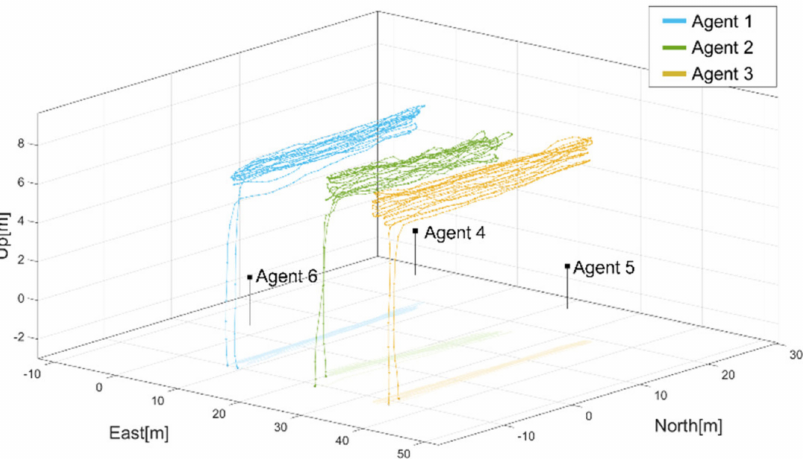
Figure 16. Flight trajectories of agents 1,2, and 3 during the